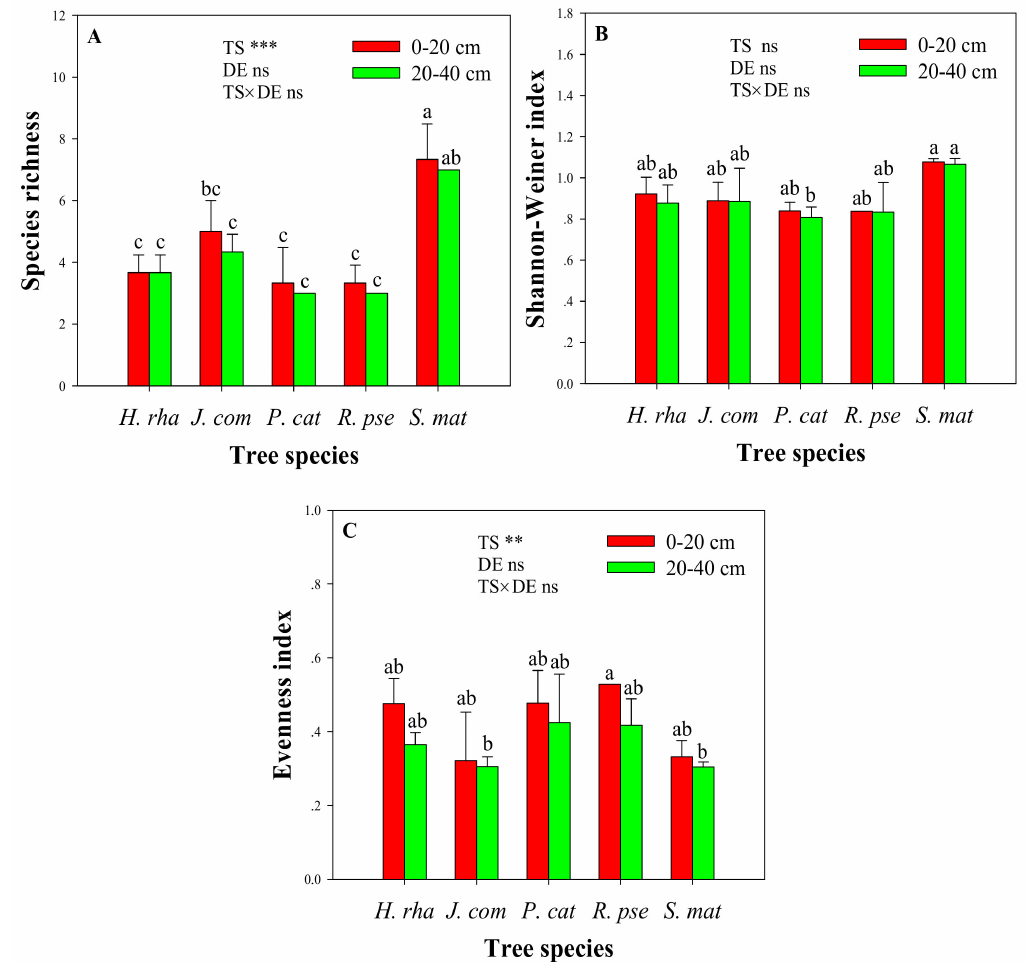
Figure 4. Di ff erences in species richness ( A ), Shannon–Wiener index ( B ) and evenness index ( C ) of arbuscular mycorrhizal fungal communities in the rhizosphere of five dominant tree species at two soil depths. Two-way ANOVA displayed the e ff ect of soil depth (DE), tree species (TS), and the interaction e ff ect (TS × DE) on species richness, Shannon-Wiener and Evenness indices (ns, non-significant; ** p < 0.01; *** p < 0.001). Deviation bars mean standard deviation. Bars followed by lowercase letters are significantly di ff erent between two soil depths and among five tree species ( p < 0.05).